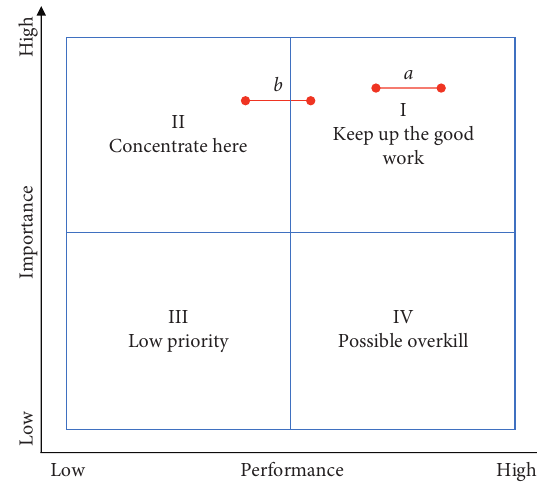
Figure 2: Revised IPA